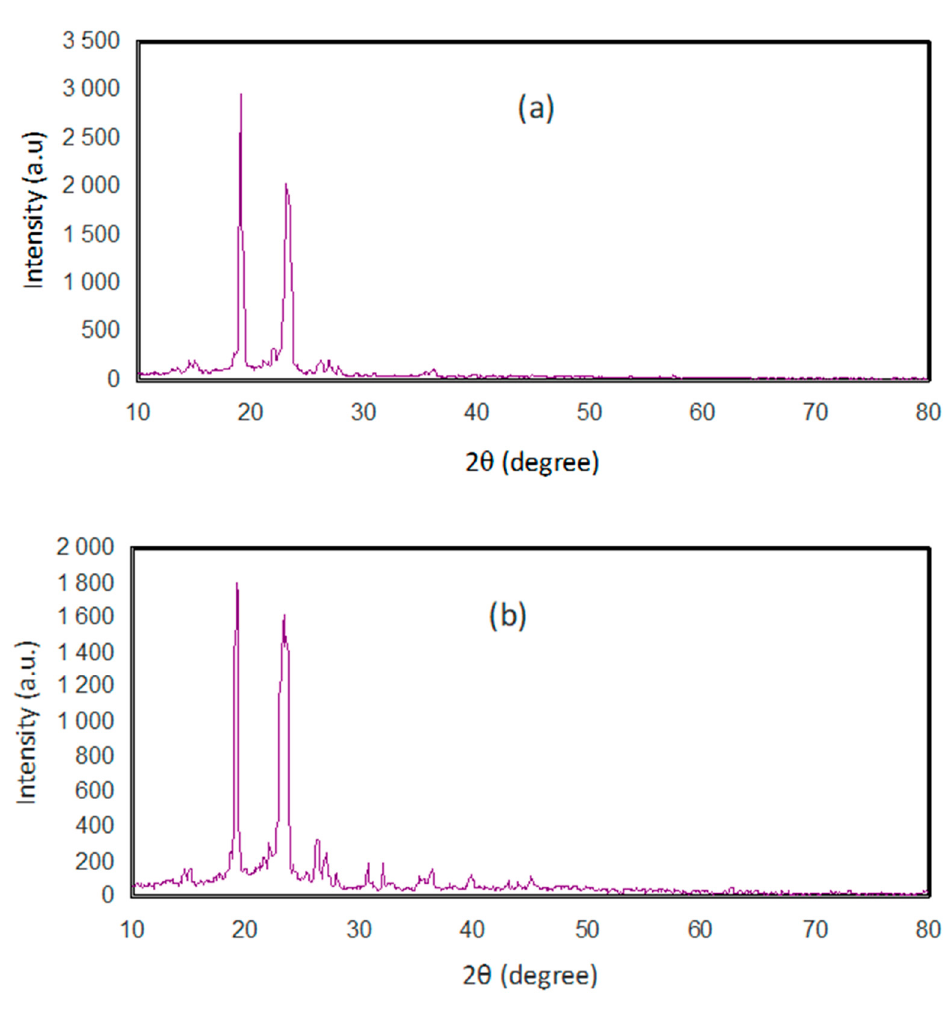
Figure 1. XRD pattern of for ( a ) PESNT0 and ( b ) PESNT1 composite films.